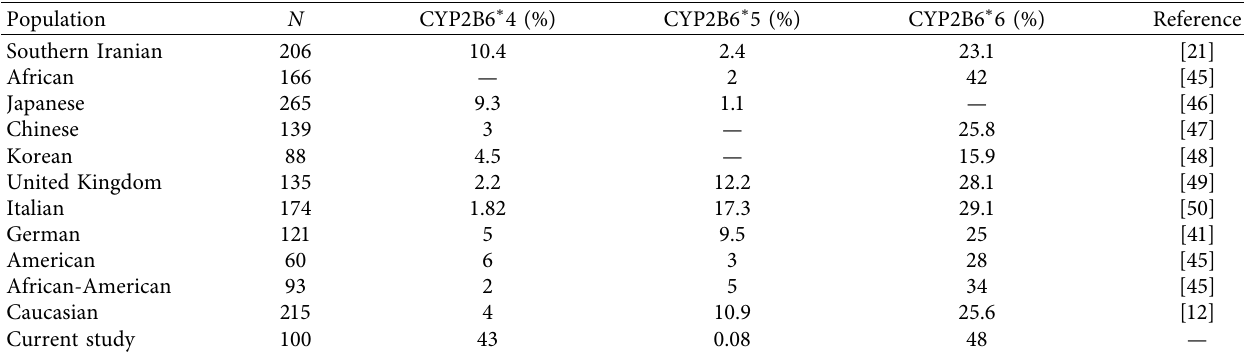
Table 4: The frequencies of CYP2B6 different alleles in different populations.